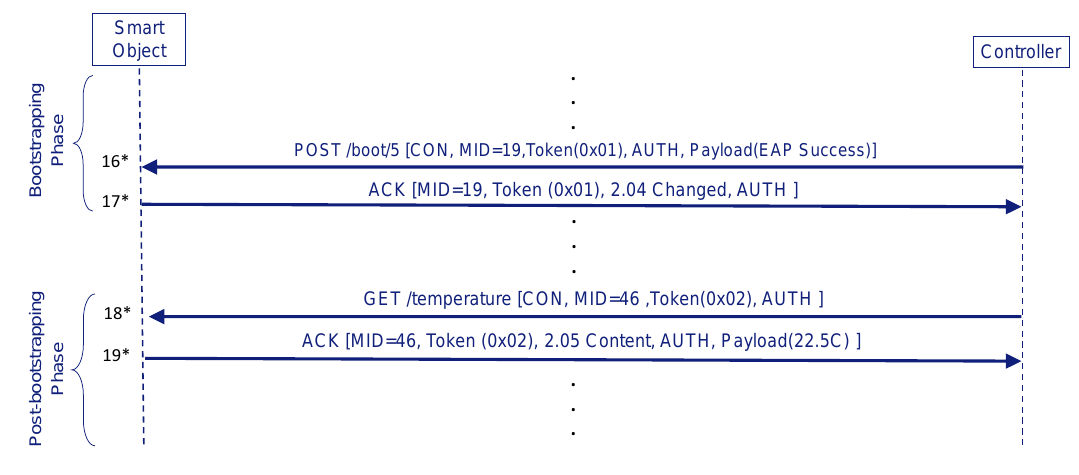
Figure 5. AUTH-based protection